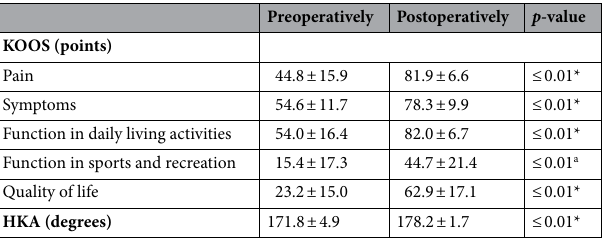
Table 1. Knee injury and osteoarthritis outcome scores (KOOS) and hip-knee-ankle angle (HKA). *A paired t-test. a Wilcoxon signed-rank test.